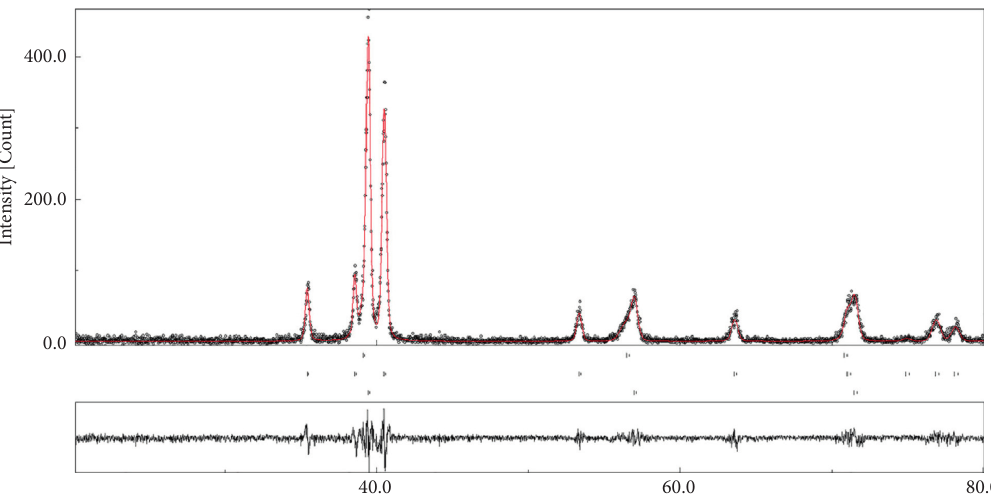
Figure 2: XRD pattern of the as-received